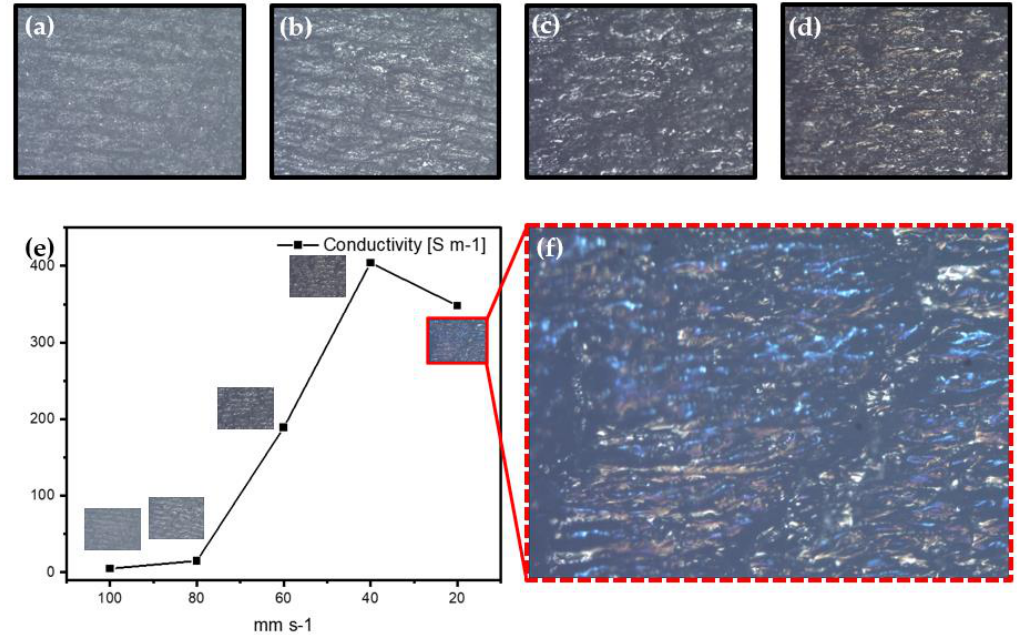
Figure 7. ( a – d ) Optical microscope images of overlapped patterns fabricated at 100, 80, 60 and 40 mm / s; ( e ) graph of the conductivity measurement according to laser speed; and ( f ) laser-induced colorful patterns fabricated at 20 mm/s.